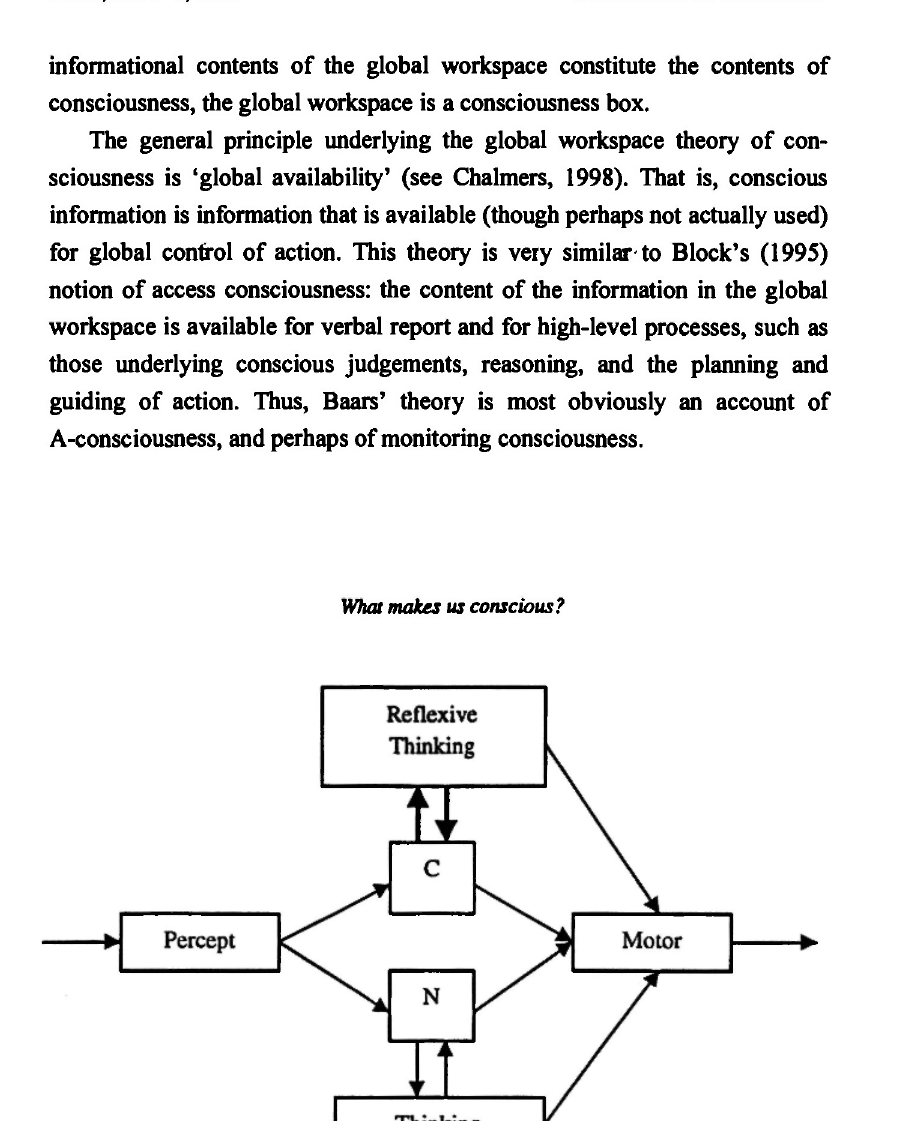
Fig. 4: A slightly simplified version of Carruthers' (1996) model. Sensory- perceptual information is passed to the short-term memory systems, C (for conscious) and Ν (for non-conscious). Information in C becomes conscious in virtue of it being available to the Reflexive Thinking